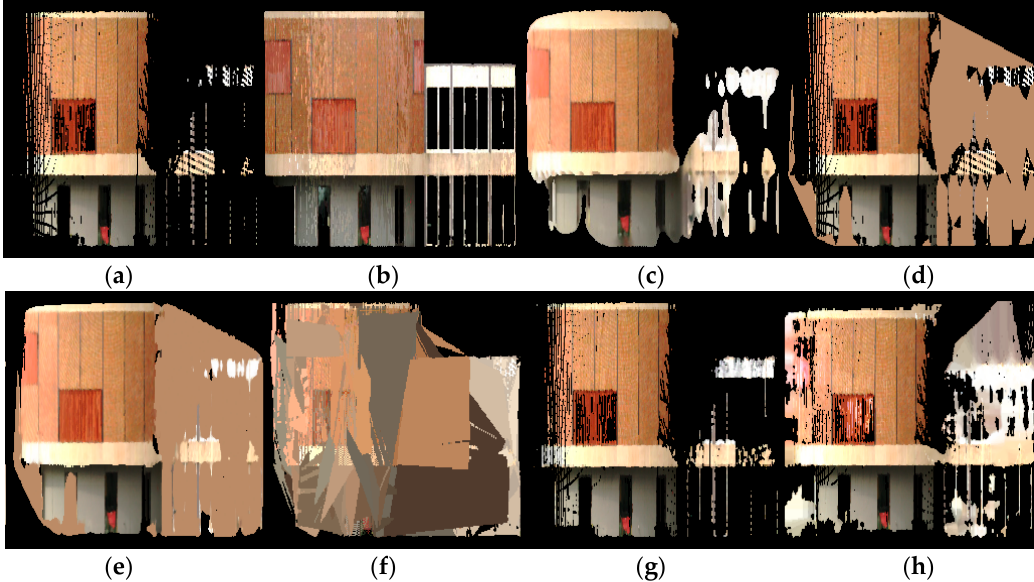
Figure 11. Point cloud scene completion results for the Van Leer building, visualized in 2D: ( a ) input point cloud, ( b ) target ground truth, ( c ) Poisson reconstruction, ( d ) hole-filling, ( e ) hybrid, ( f ) plane-fitting, ( g ) partial convolution, and ( h ) proposed.